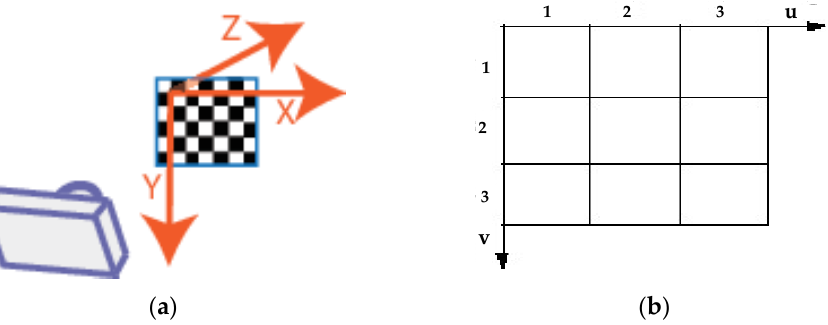
Figure 4. The reference frames. ( a ) 3D coordinate system. ( b ) pixel coordinate system.